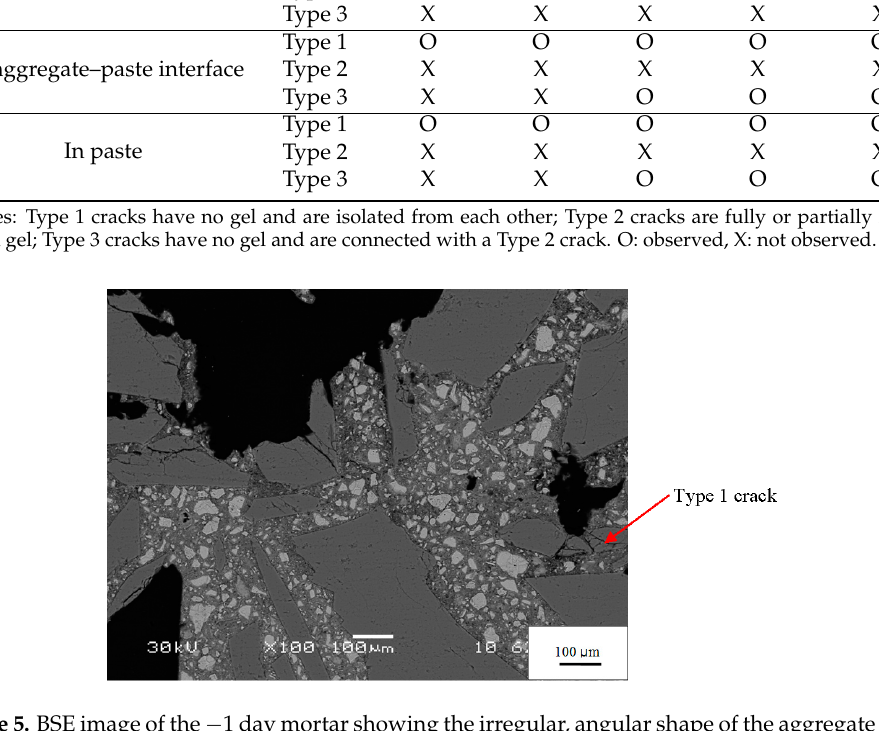
Figure 5. BSE image of the − 1 day mortar showing the irregular, angular shape of the aggregate grains and their unfilled cracks.